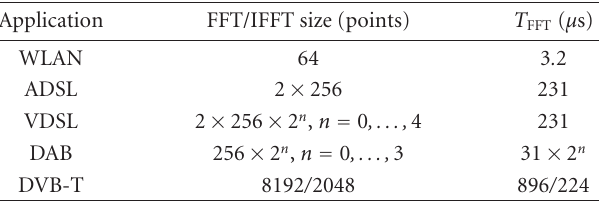
Table 1: FFT/IFFT size for OFDM-based communication